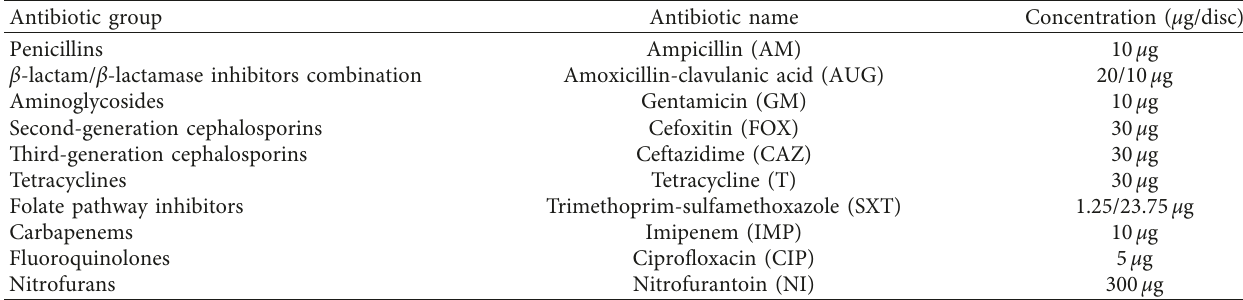
Table 1: Details on antibiotics used in this study.